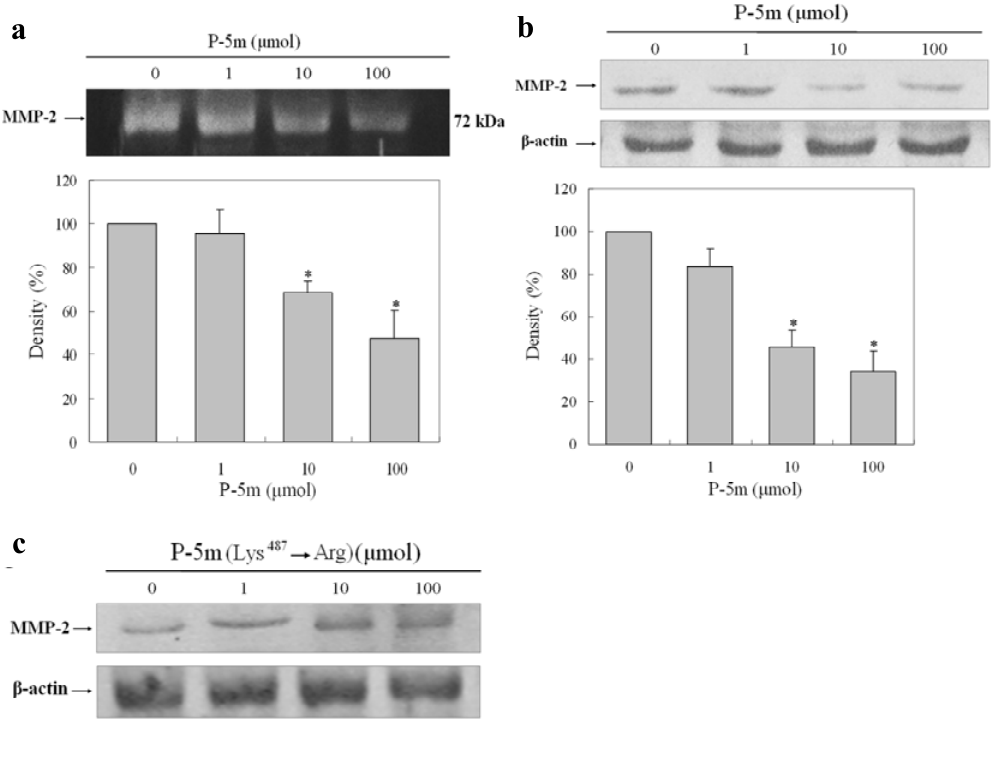
Figure 1. Effect of P-5m and P-5m (Lys 487 → Arg) mutant on MMP-2 secretion in HCCLM3 cells. ( a ) HCCLM3 cells were cultured with or without P-5m for 36 h. The conditioned media were analyzed by zymography. ( b , c ) HCCLM3 cells were cultured with or without P-5m/P-5m mutant for 36 h. The protein levels of MMP-2 from whole-cell lysates were analyzed by Western blotting with β -Actin as a control. Bars represent mean ± SD of three independent experiments. * P <